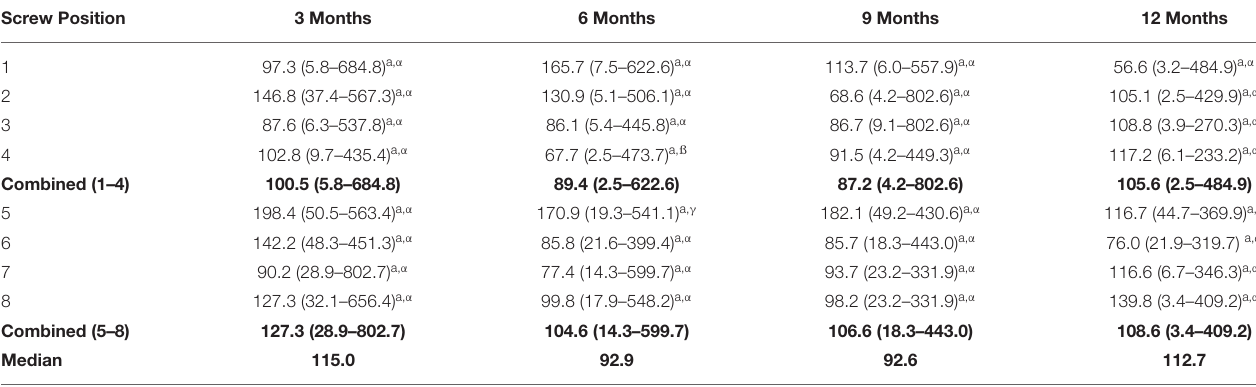
TABLE 1 | Peak Reverse Torque (PRT) measurements.